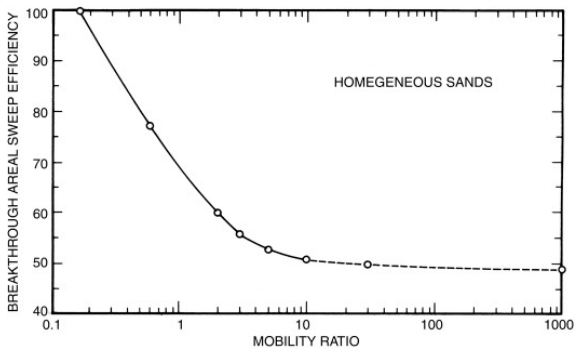
Figure 12. The e ff ect of mobility ratio on areal sweep e ffi ciency at Figure 12. The effect of mobility ratio on areal sweep efficiency at breakthrough .